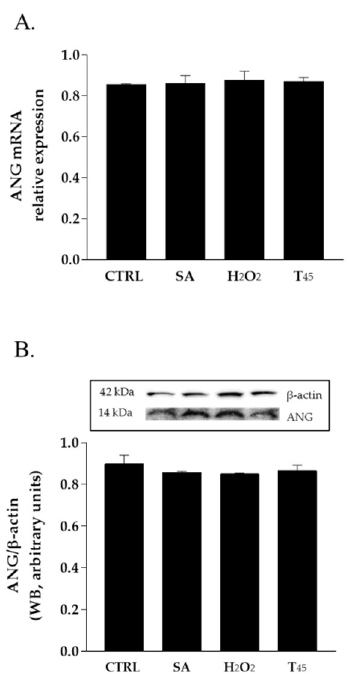
Figure 1 . Analysis of ANG expression level in HaCaT cells cultured in different growth conditions. ( A ). Expression analysis of ANG mRNA by RT-qPCR; ( B ). Western blot analysis of cell lysates. CTRL: cells cultured in physiological conditions; SA: HaCaT cells treated with 500 µM sodium arsenite (SA) for 1 h at 37 °C; H 2 O 2 : HaCaT cells treated with 1 mM of hydrogen peroxide for 2 h at 37 °C; T 45 : HaCaT cells subjected to thermal stress at 45 °C for 1 h.